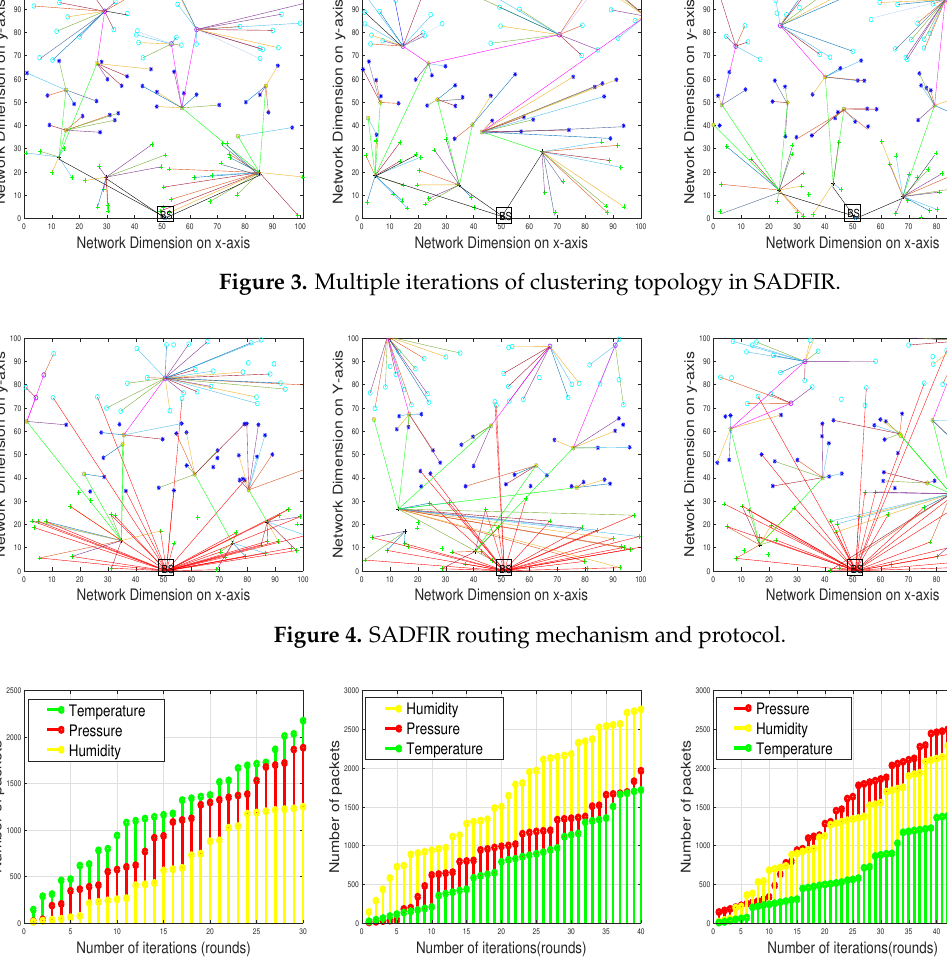
Figure 5. Application-aware and environment-sensing of SADFIR routing